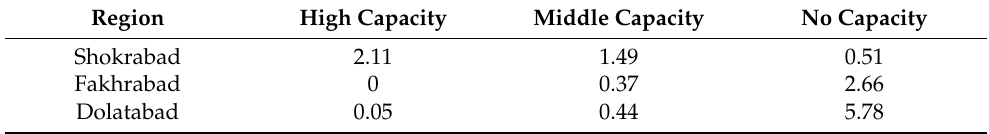
Table 6. The area (km 2 ) of different classes of recreation potential (with multicriteria evolution).